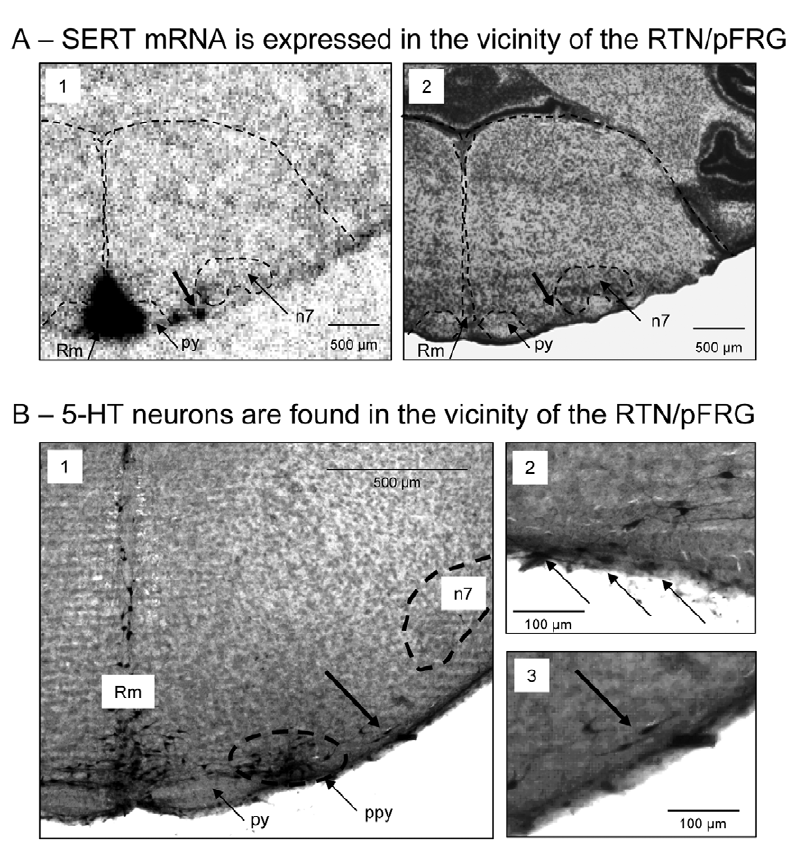
Figure 3. SERT mRNA and 5-HT-containing neurons in the vicinity of the RTN/pFRG of neonatal mice. A: Two serial coronal sections passing through the RTN/PFRG area of a neonatal mouse show SERT mRNA expression (A1) and Cresyl Violet staining (A2). Anatomical limits drawn from A2 Cresyl Violet section have been superimposed on A1 section (dotted line). Note SERT mRNA is expressed in three areas, the median Raphe Magnus (Rm), the para-pyramidal group (ppy) lateral to the pyramid tract (py) and a lateral spot (arrow) located in a medio-ventral position from the facial motor nucleus (n7), as defined from Cresyl Violet staining (in A2). B- 5-HT neurons in the RTN/pFRG area of a neonatal mouse. Note 5-HT neurons in the median raphe magnus (Rm), the parapyramidal group (ppy, doted circle) lateral to the pyramidal tract (py) and the lateral spot (arrow in B1) in the medio-ventral location of the facial nucleus (n7). In B2 and B3, note the superficial location of some 5-HT neurons (arrows). B3 is an enlargement of